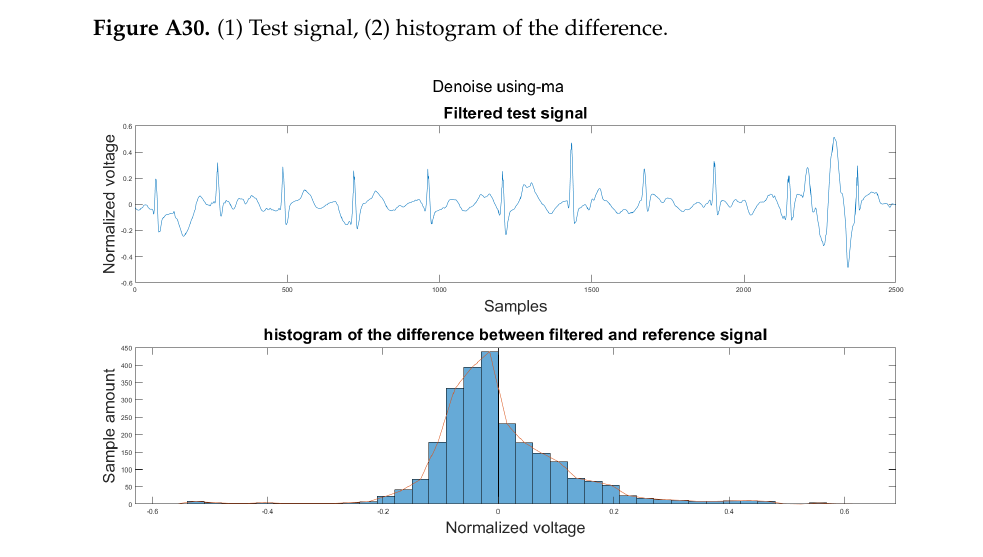
Figure A31. (1) Test signal, (2) histogram of the difference.